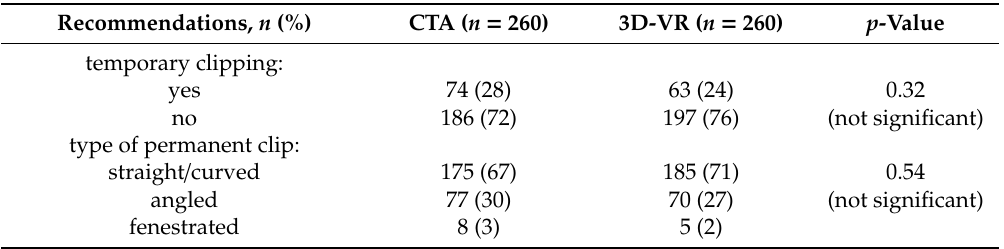
Table 6. Recommended clipping strategy * after presenting conventional CTA images (2D and screen 3D) or reconstructed 3D-VR images, evaluated using Fisher’s exact test, assuming a p -value < 0.05 to be